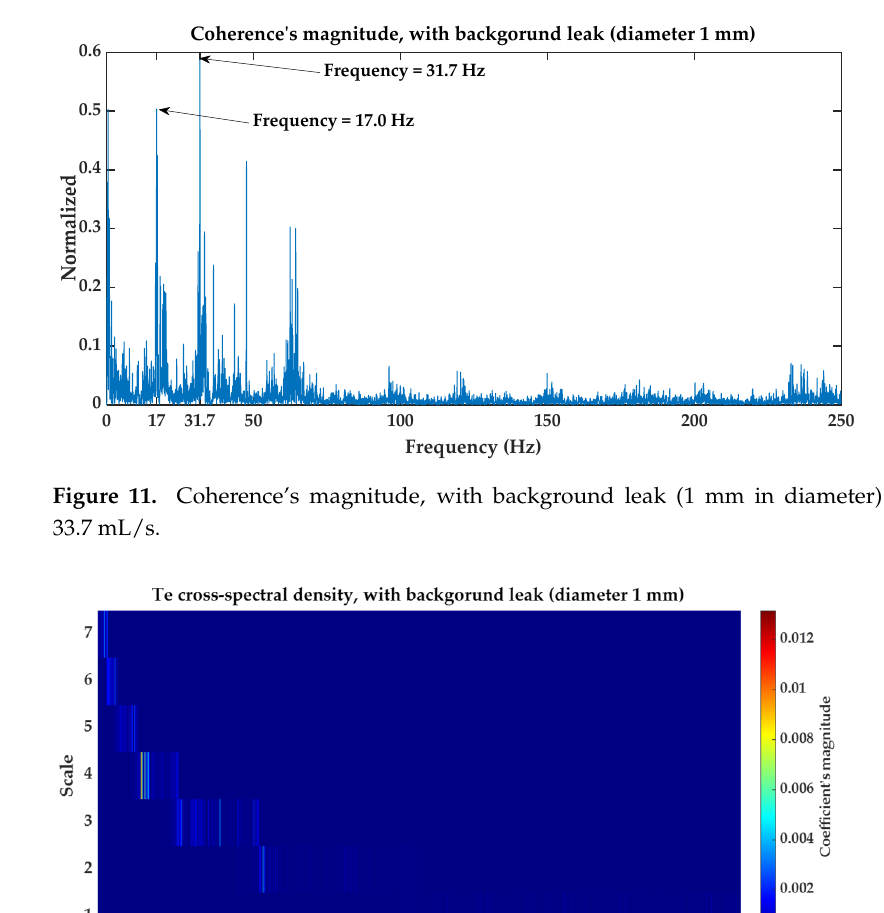
Figure 10. Cross-spectral density, with background leak ( 1 mm in diameter) and flow rate 33.7 mL/s .